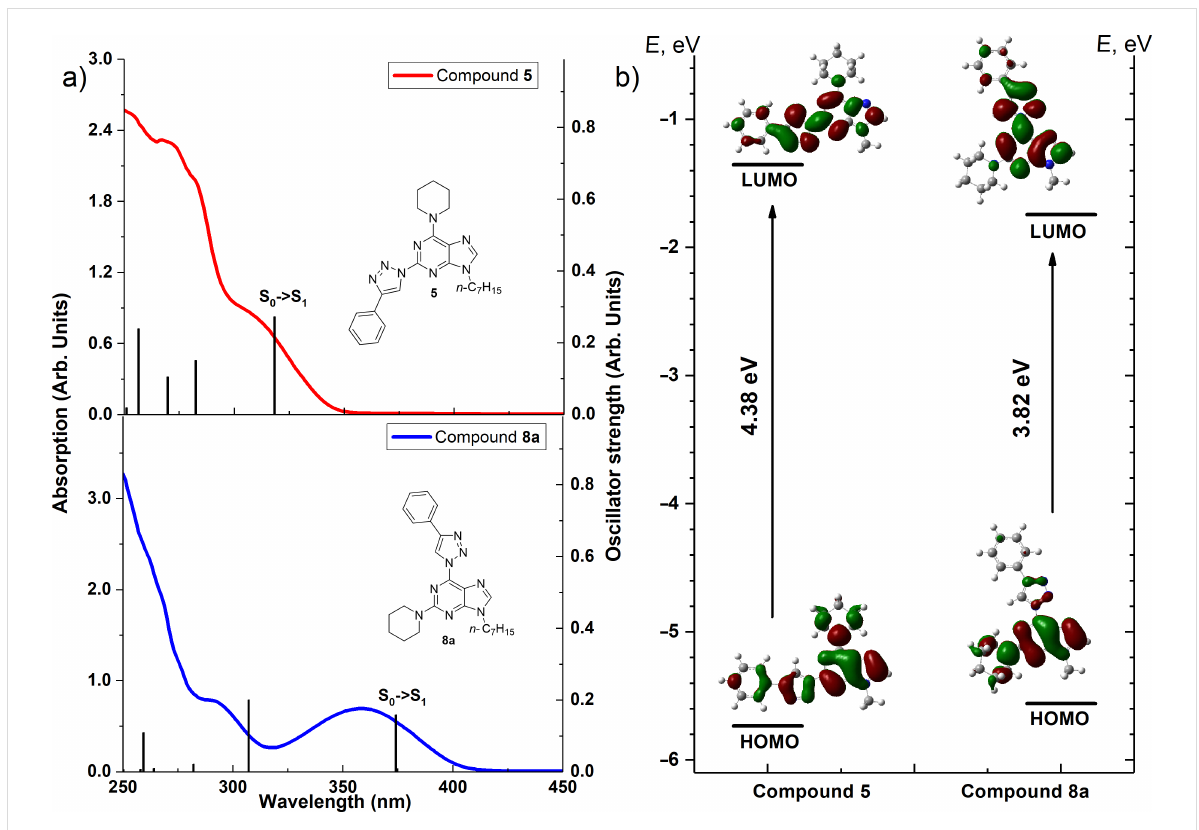
Figure 4: a) Experimental UV–vis absorption spectra (lines) with computed theoretical absorption bands (columns) of compounds 5 and 8a ( c = 10 − 4 M). b) Energy diagram and spatial distribution of frontier molecular orbitals (at isosurface value 0.02) of compounds 5 and 8a .